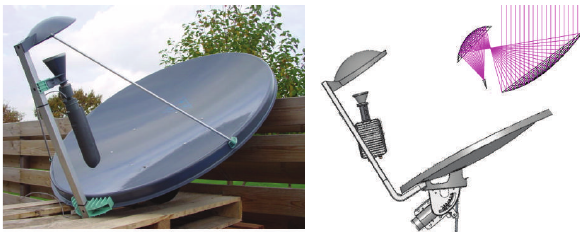
Figure 1: The general structure of a dual-reflector antenna. The static subreflector (shown on the upper part of the figure) was replaced with a dynamic surface